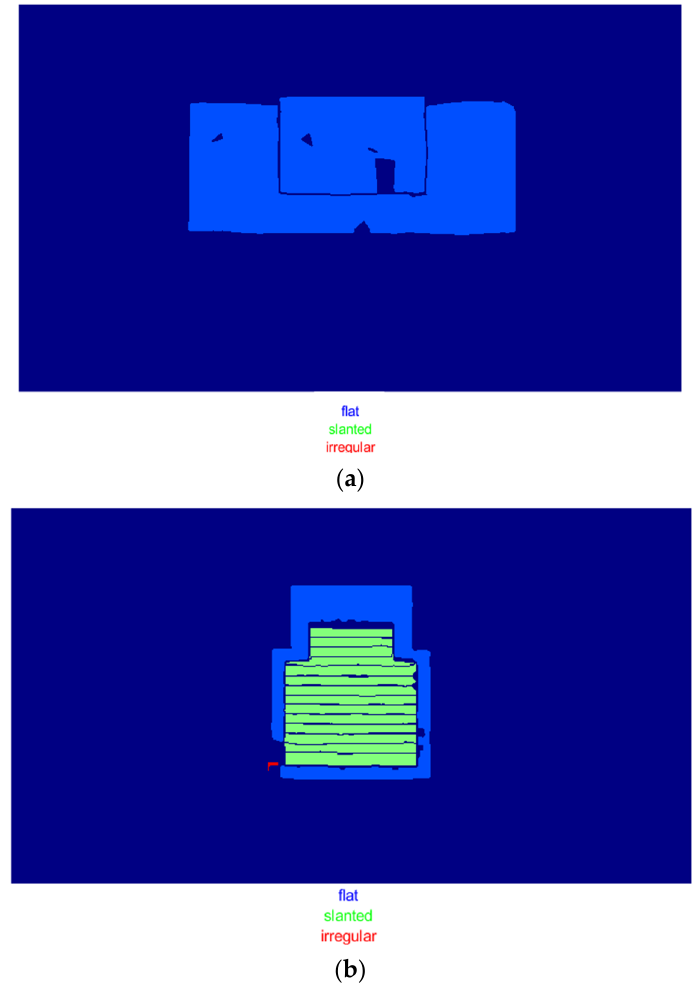
Figure 9. Rooftop classification result of ( a ) ADMIN building and ( b ) CAM building.